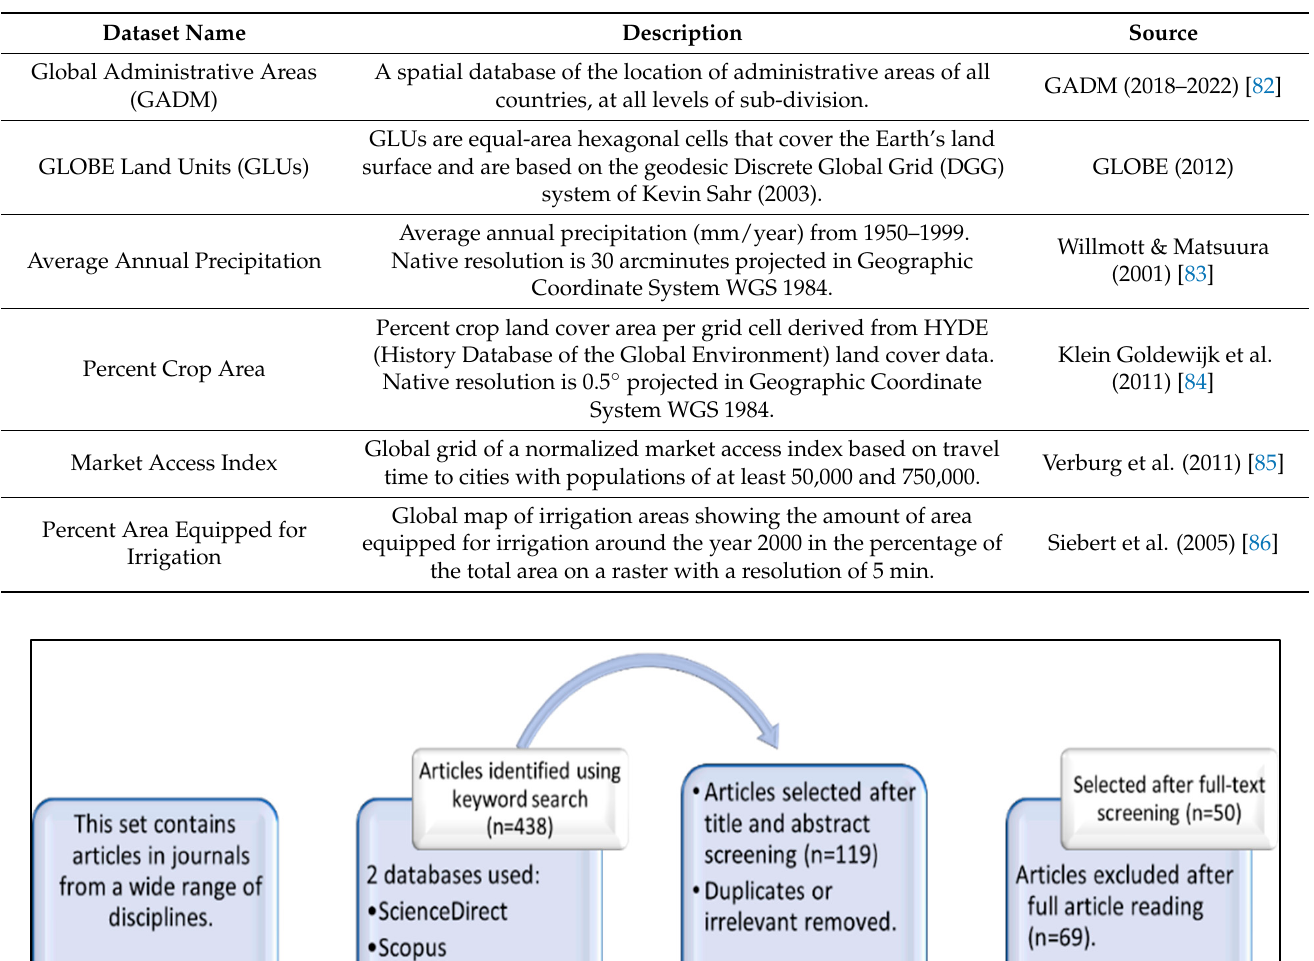
Table 1. Description and sources of all the datasets used in this analysis.